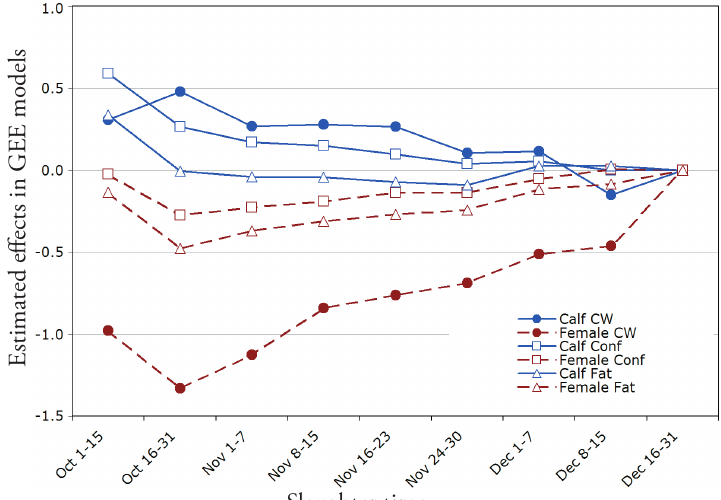
Fig. 2. Estimated effects of slaughter time on carcass weight (CW), confor- mation score (Conf) and fatness score (Fat) for calves and females accord- ing to GEE models. Note that the estimates were obtained with the period December 16-31 as the reference point (estimate set to 0). Intercepts for the different carcass measures and animal categories are found in